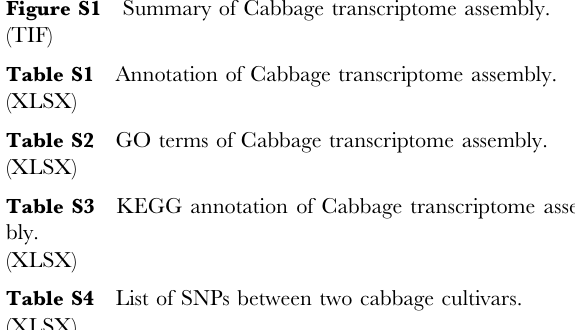
Table S5 Tissue-specific locus candidates of Cabbage transcrip- tome assembly. Table S6 GO terms of Tissue-specific locus candidates. Table S7 Thirty tissue-specific locus candidates for RT-PCR. Table S8 Primer sets for